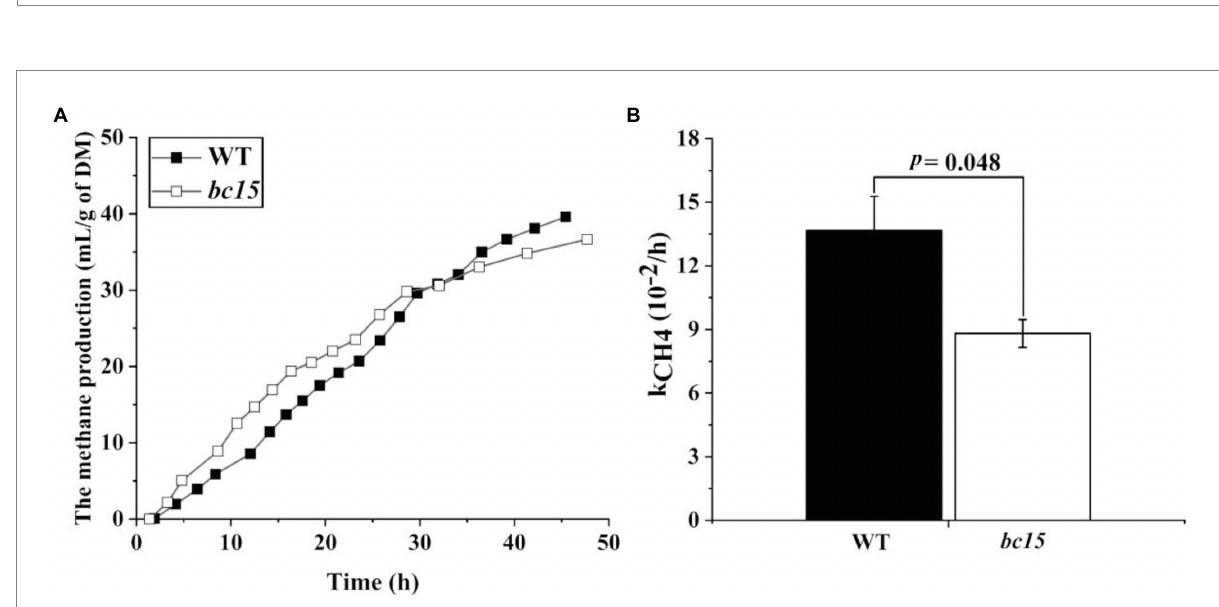
FIGURE 2 The kinetics of ruminal methane (CH 4 ) production (A) and its fractional rate of CH 4 production (k CH4 , 10 − 2 /h; B ) of wild-type (WT) and brittle culm 15 ( bc15 ) mutant rice straws after 48-h in vitro ruminal incubation ( n = 3). Data with error bars are expressed as mean ± standard error.